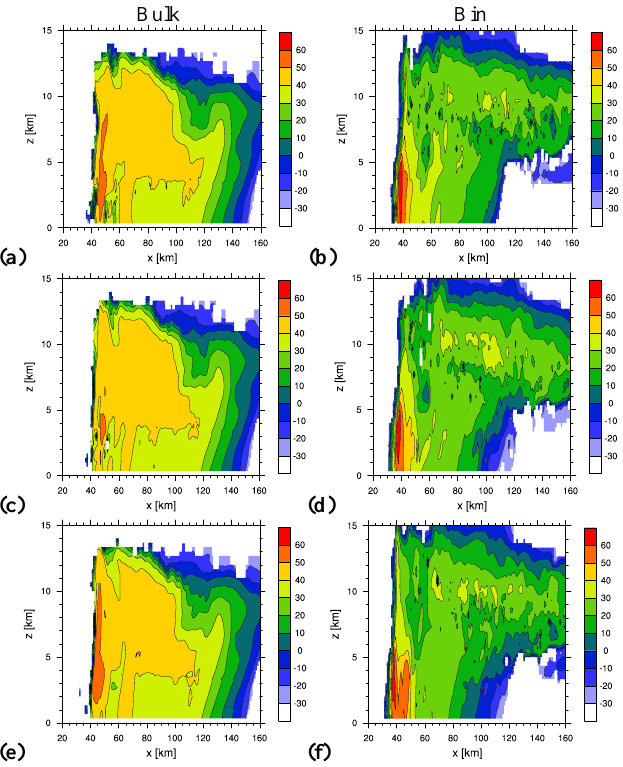
Fig. 8. Zonal vertical transects of the radar reflectivity factor ( Z ) in dBZ. The transects are taken after 2 hours of simulation for y = 125 km. ( a , c , and e ) are for the simulations with bulk mi- crophysics and ( b , d , and f ) are for the simulations with bin mi- crophysics. The “Clean” ( a and b ), “Semi-Polluted” ( c and d ), and “Polluted” ( e and f ) cases are